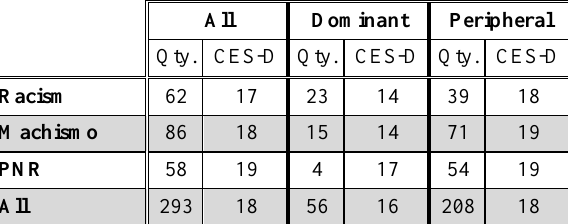
Table 12 : CES-D based on oppression report type